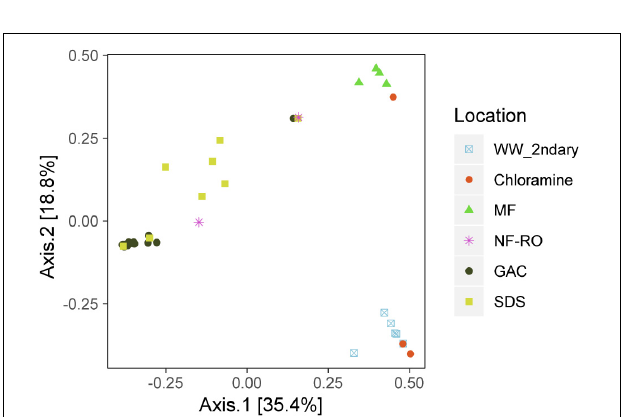
FIGURE 4 | Bacterial community dissimilarity by location. Principle coordinate analysis (PCoA) of amplicon data based on Bray-Curtis dissimilarity. Locations within the advanced treatment train are indicated by color and shape and include secondary wastewater (“WW_2ndary”), chloramine treated (“Chloramine”), MF permeate in storage tank (“MF”), NF permeate and NF permeate in storage tank (“NF-RO”), filtrates from three parallel GAC filters (“GAC”) and bulk water from three SDS